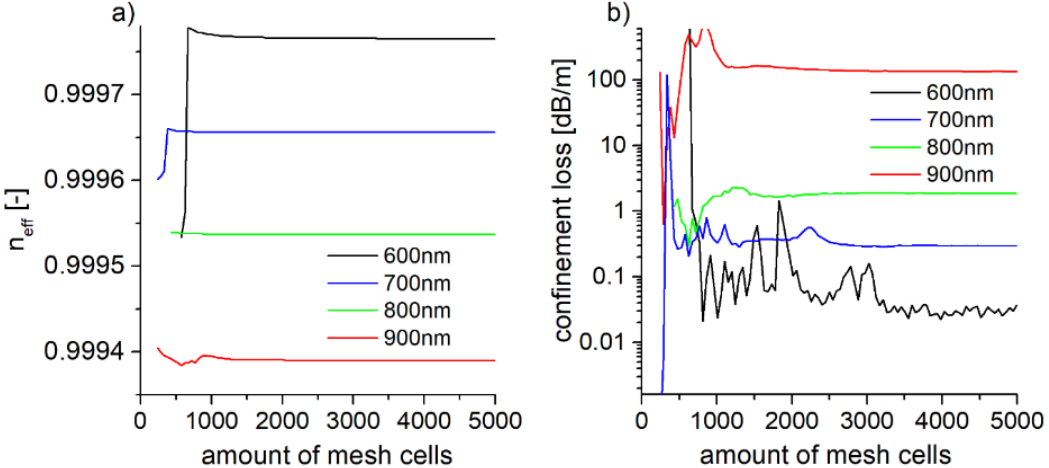
Figure 3. Calculated effective refractive index n eff ( a ) and confinement loss ( b ) for the fundamental mode of the 7-cell structure, for different amount of mesh cells ( x direction) and different wavelengths. The appropriate amount of mesh cells in y direction can be calculated from Equation (3). The convergence is obtained if the number of mesh cells is greater than 3000.